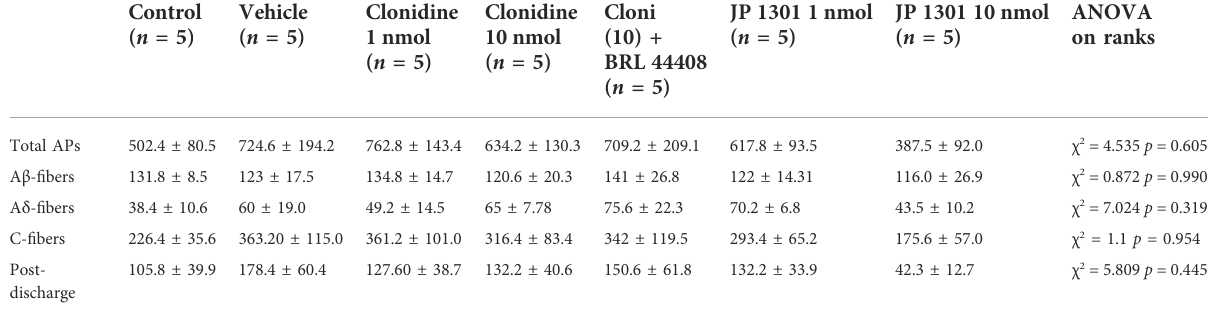
TABLE 2 Mean action potentials elicited (±s.e.m.) by twenty electrical stimuli at the basal time (t = 0) in the different experimental groups. Since the normality test failed (Shapiro-Wilk), a Kruskal-Wallis one-way ANOVA on ranks was performed to compare the action potential elicited by the different